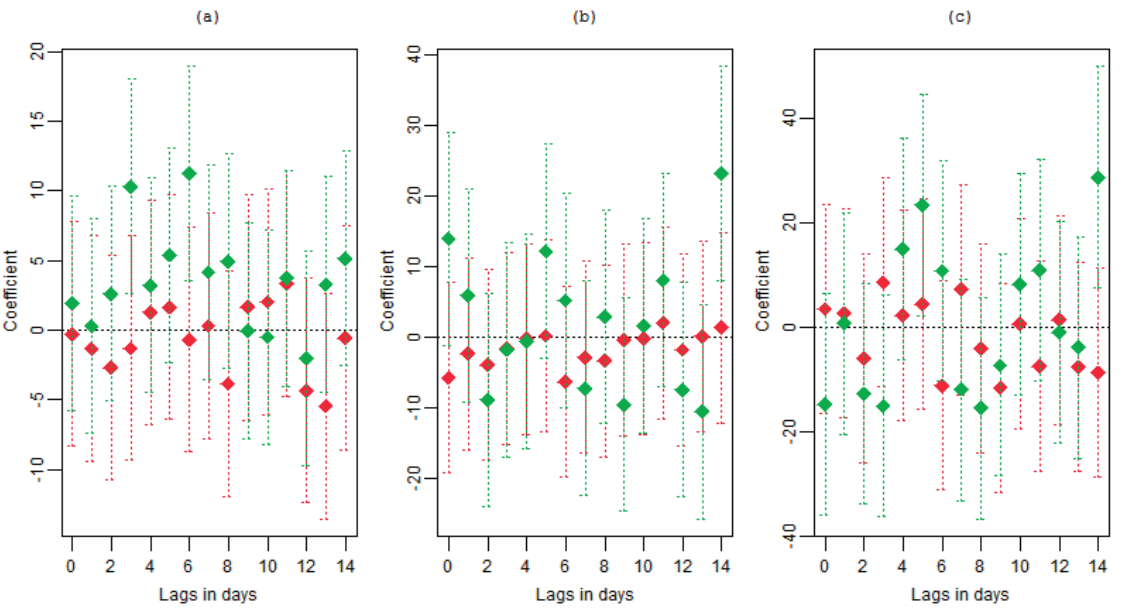
Figure 3. The delayed associations of cold spell (green) and heat wave (red) of at least two days heat wave or cold spell on years of life for different definitions: ( a ) <10th and >90th percentiles, ( b ) <5th and >95th percentiles and ( c ) <2nd and >98th percentiles.